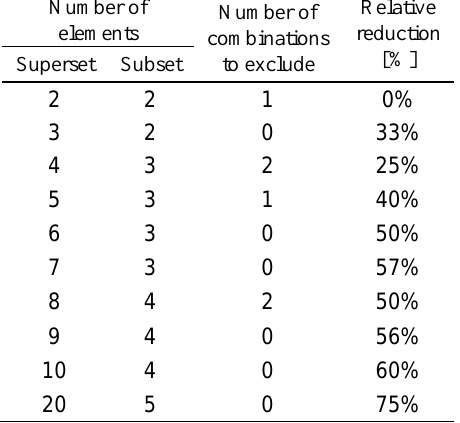
Table A.1. Minimum number of levels needed to reproduce sets of equally spaced levels from 0 to